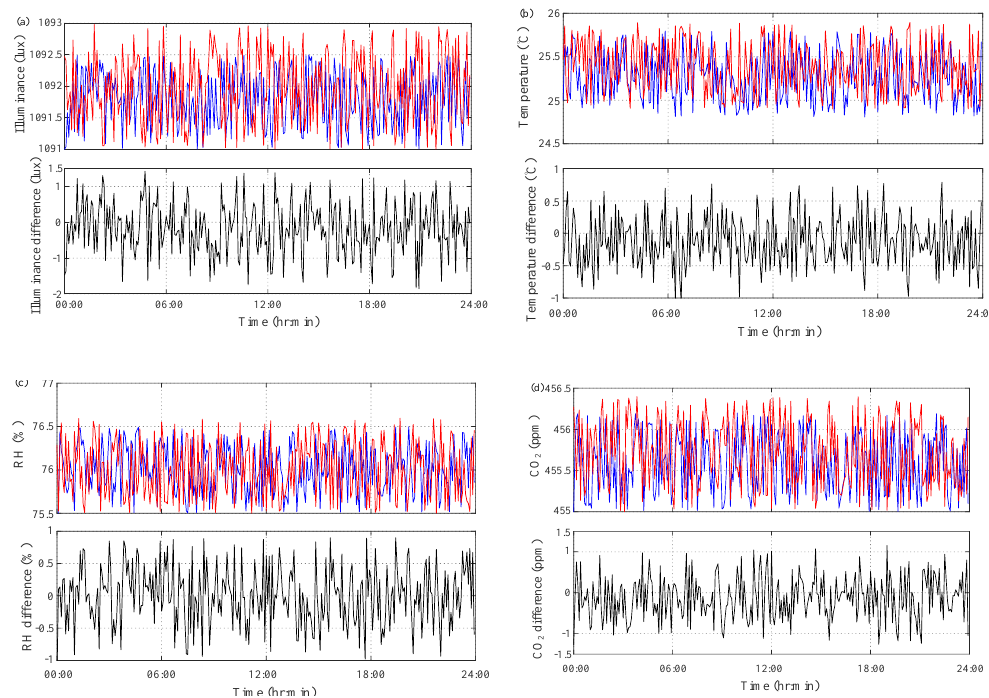
Figure 9. 24-h measurement results of post-calibration process: ( a ) illuminance; ( b ) temperature; ( c ) RH; ( d ) CO 2 (blue line—sensor; red line—instrument; black line—difference).